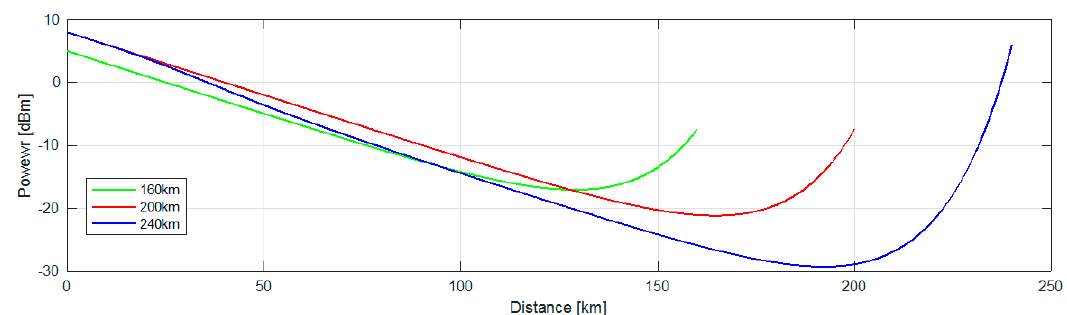
Figure 5. Constellation diagrams showing the best-case experimental result out of several configurations (see Figures 3 and 4) with (bottom) and without (top) applying DBP.